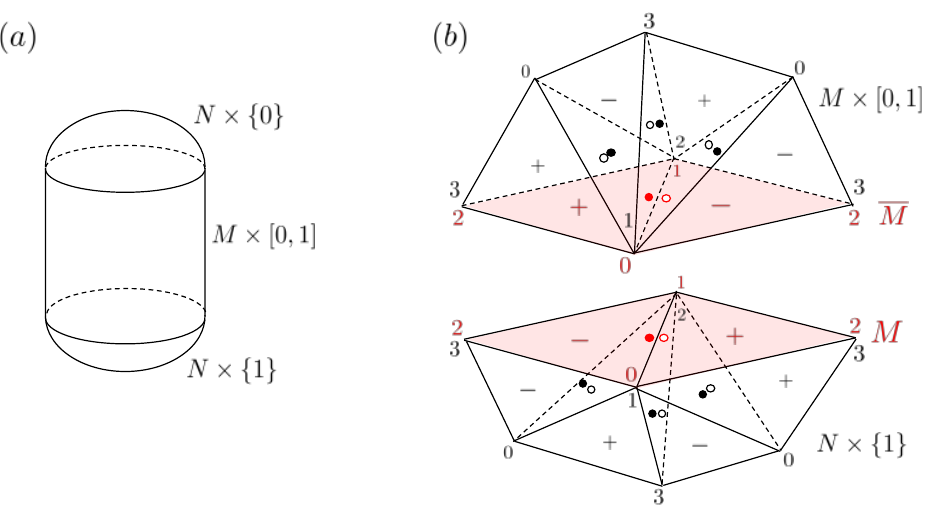
Figure 4 . ( a ): an example of K such that @K = ( N (cid:2) f 0 g ) t ( M (cid:2) [0 ; 1]) t ( N (cid:2) f 1 g ). ( b ): triangulation of M (cid:2) [0 ; 1] and N (cid:2) f 1 g near the attaching region M , in the case of d = 2. Note that (cid:18) (red dot) and (cid:18) (white dot) are (cid:13)ipped from the original assignment rule on M in the side of N (cid:2) f 1 g , which makes (cid:27) ( N (cid:2) f 1 g ) = 1 when (cid:11) ( e ) is nonzero on a single ( d (cid:0) 1)-simplex on M . In contrast, we have (cid:27) ( M (cid:2) [0 ; 1]) = (cid:0) 1 in such a